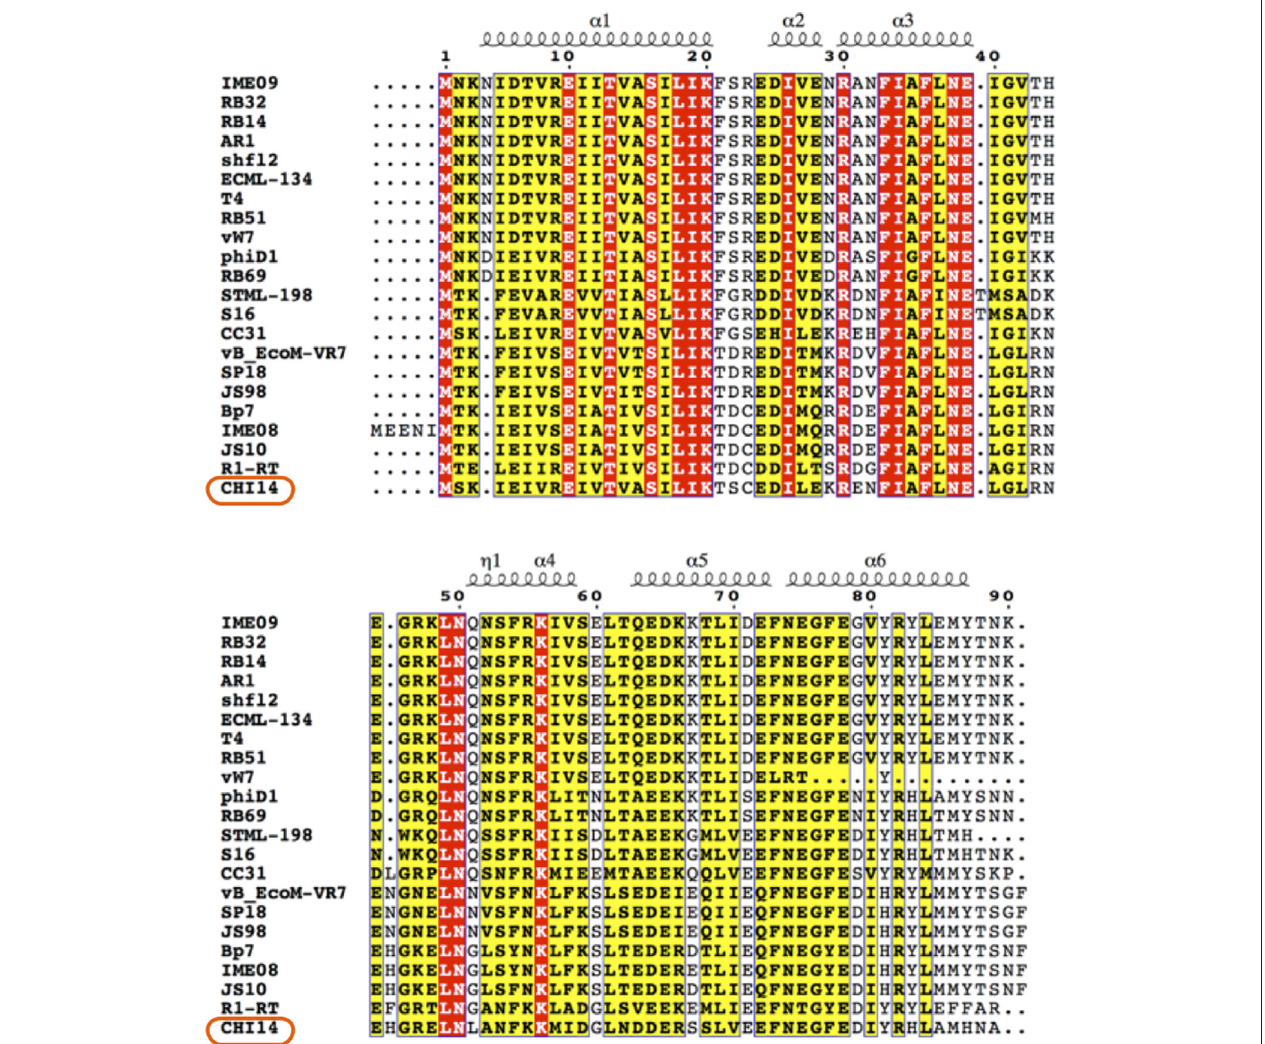
FIGURE 7 | Alignment of AsiA from 8 CHI14 and related phages. The N-terminal region of AsiA is highly conserved among phages while the C-terminal region is more varied. The protein secondary structure prediction is overlaid on the